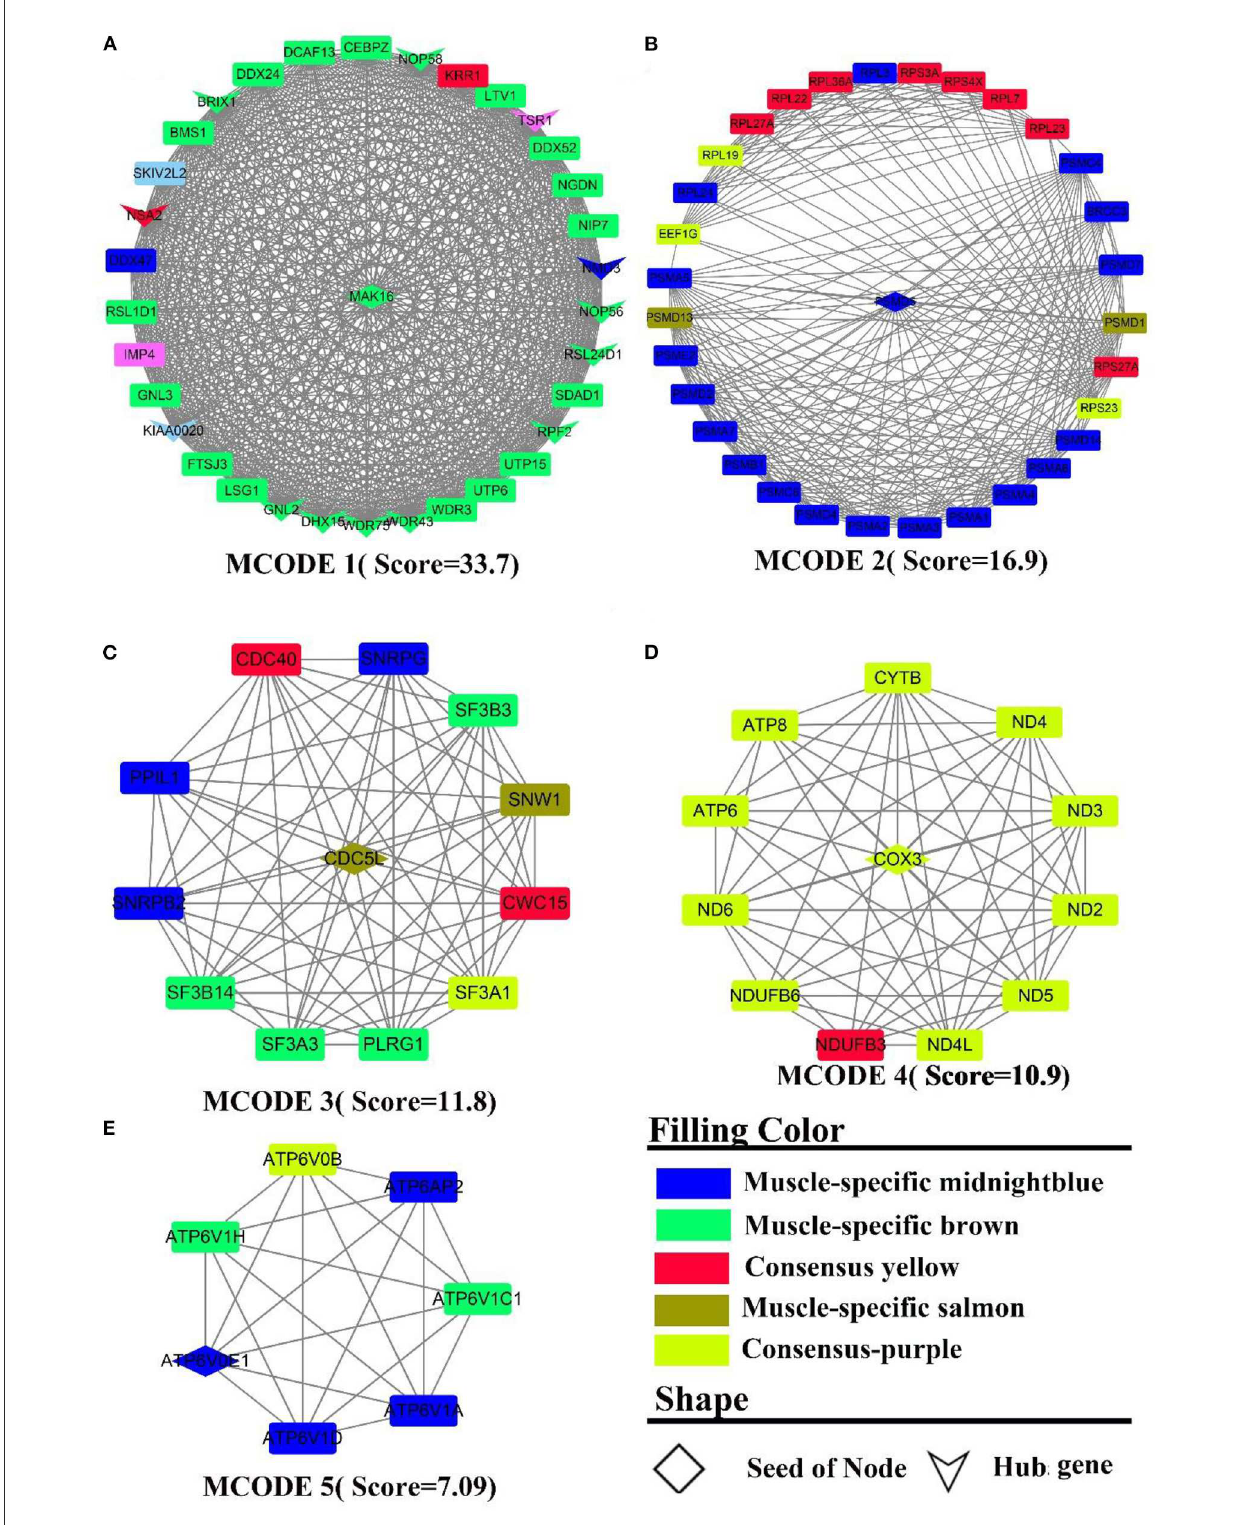
FIGURE5 PPI and hub gene analysis for genes in LM regulatory axis. The color and shape represented gene source and gene type, respectively.